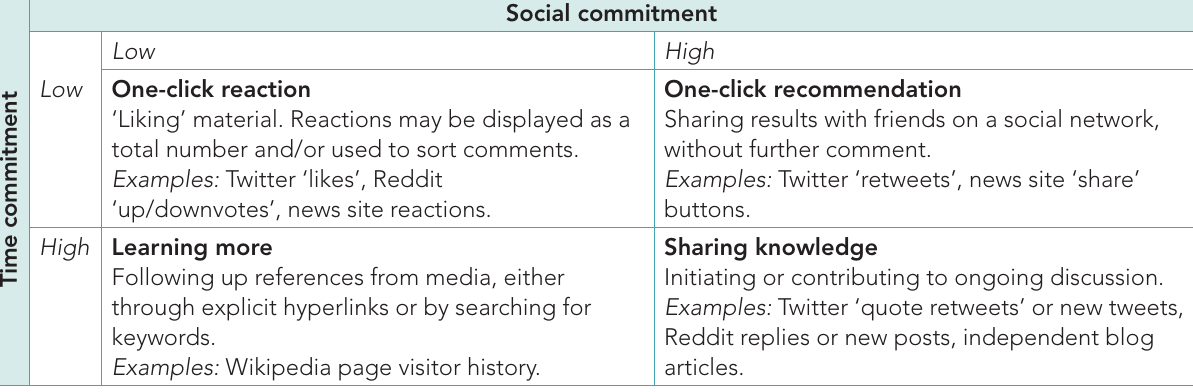
Table 1. Schema of different generic ways to engage with online material on news sites or social